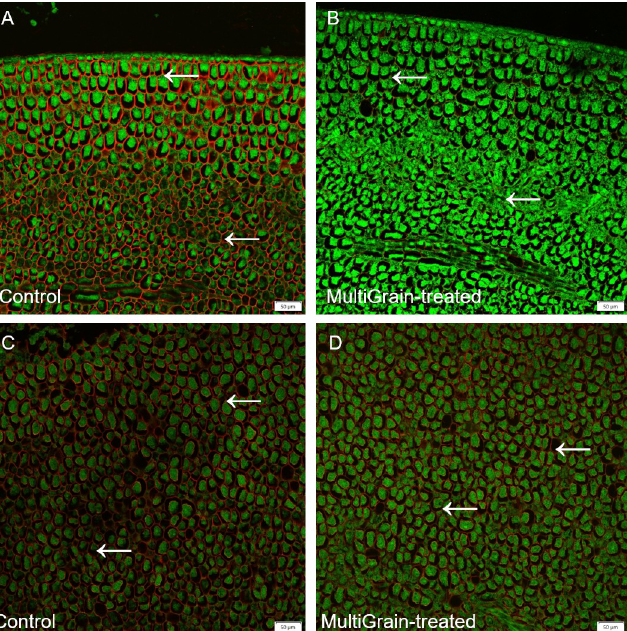
Fig 8. Confocal images of cross sections of whole sunflower seeds. Sections of sample incubated (A, C) with sodium acetate buffer (control) or (B, D) with MultiGrain for 3 hours at pH 5. Slides were subsequently incubated (A, B) with the LM25 antibody detecting xyloglucans with different branching structures or (C, D) with the antibody detecting (1– 5)- α -L-arabinans. Red fluorescence labelled secondary antibody used for visualization of sections. Red signal indicates (A, B) xyloglucans having highly branched substitutions or (C, D) ( 1–5)- α -L-arabinans and the green signal indicates autofluorescence from proteins bodies. Arrows point to sites where the fluorescence signal due to staining or immunolabelling is present and removed following treatment with MultiGrain. Scale bar = 50 μ m.